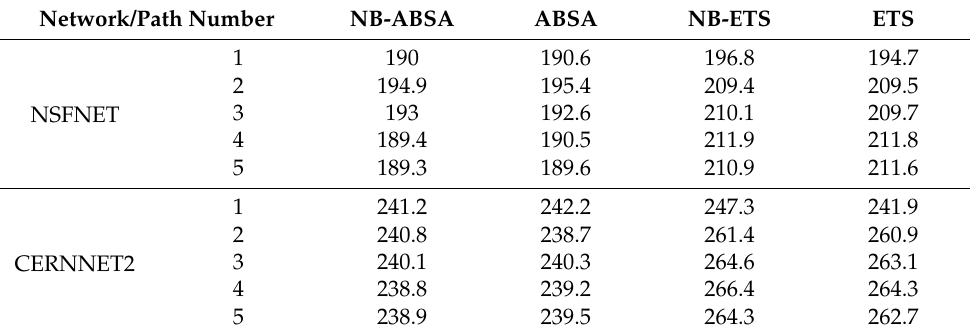
Table 2. Network service traffic of heuristic SFC deployment algorithm based on NBACO-SS.